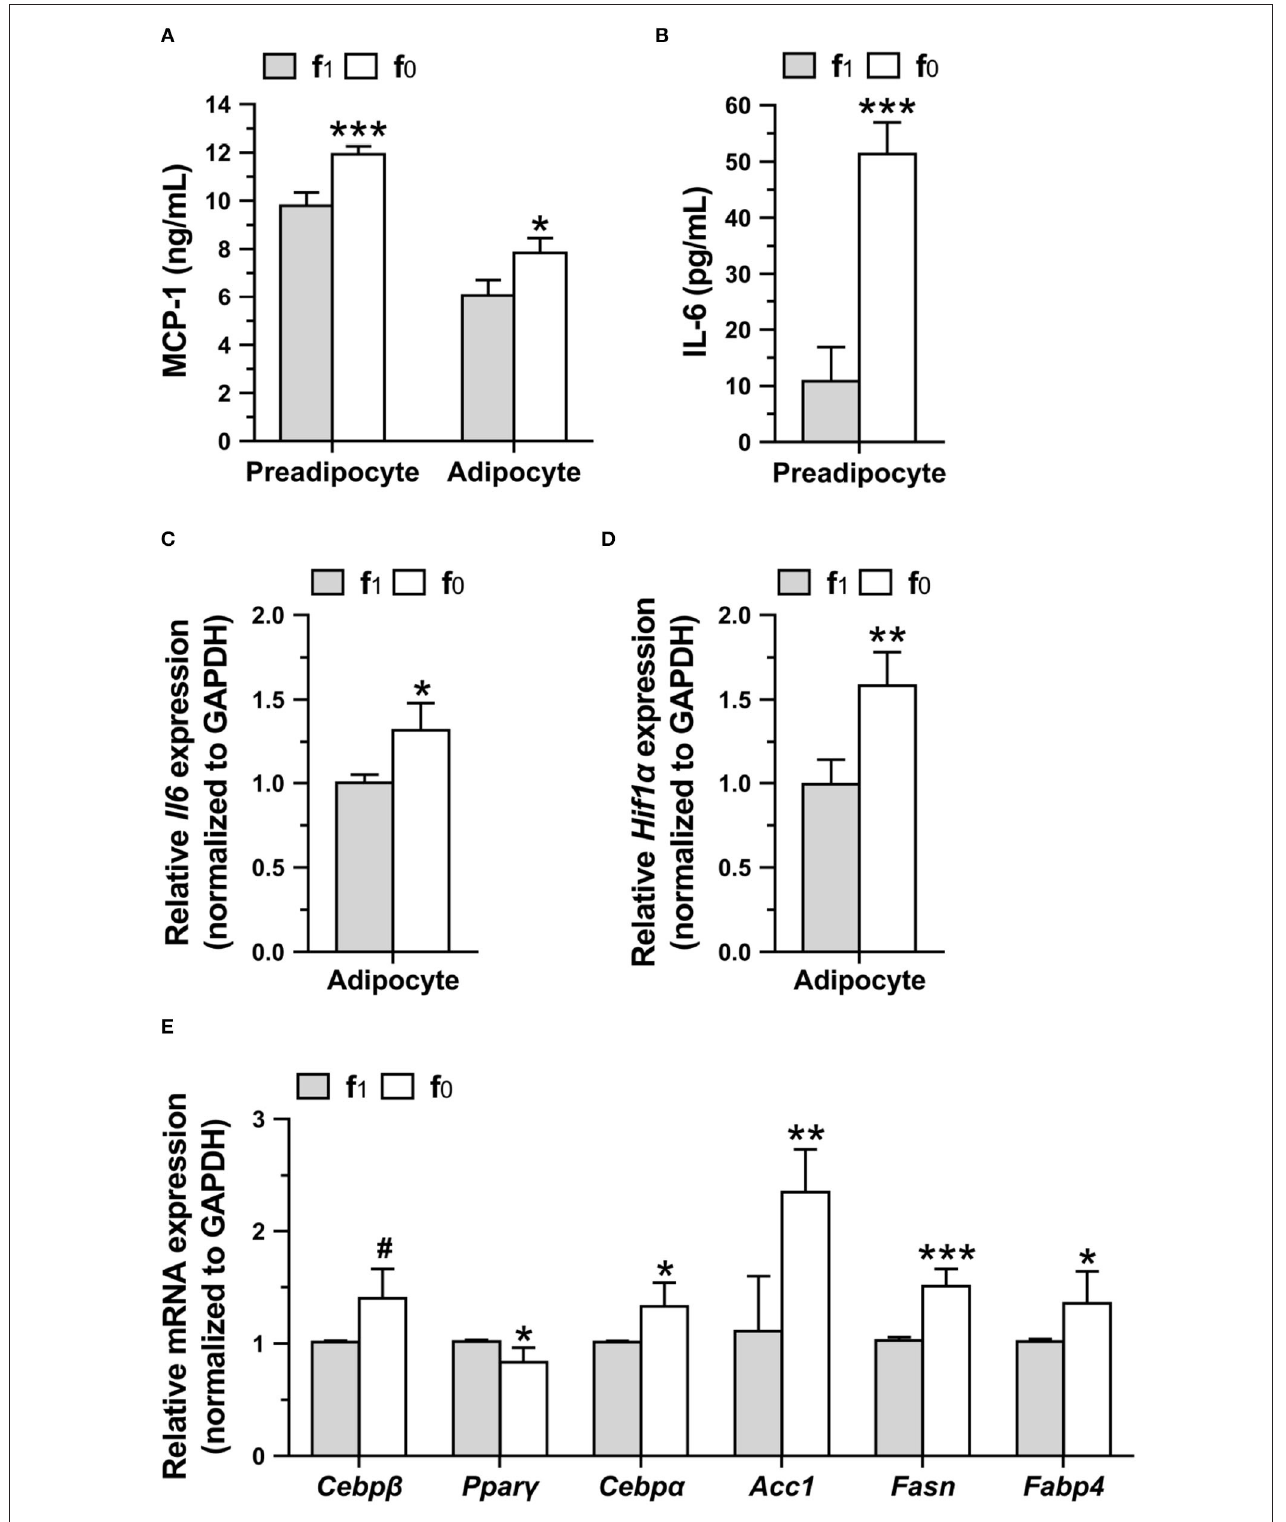
FIGURE 8 | Folate deficiency increased proinflammatory cytokine productions and lipogenic gene expressions of 3T3-L1 cells. Preadipocytes were cultured in medium with (f 1 ) or without (f 0 ) folate for 4 days, and adipocytes were differentiated for 16 days. (A) MCP-1 and (B) IL-6 secretions by preadipocytes or adipocytes were analyzed using ELISA. The relative expressions of (C) Il6 and (D) Hif1 α , and (E) lipogenic genes in adipocytes were performed by qPCR assay. Data are mean ± SD ( n = 4). # 0.05 < p < 0.1, * p < 0.05, ** p < 0.01, and *** p < 0.001 vs. f 1 group by Student’s t -test.